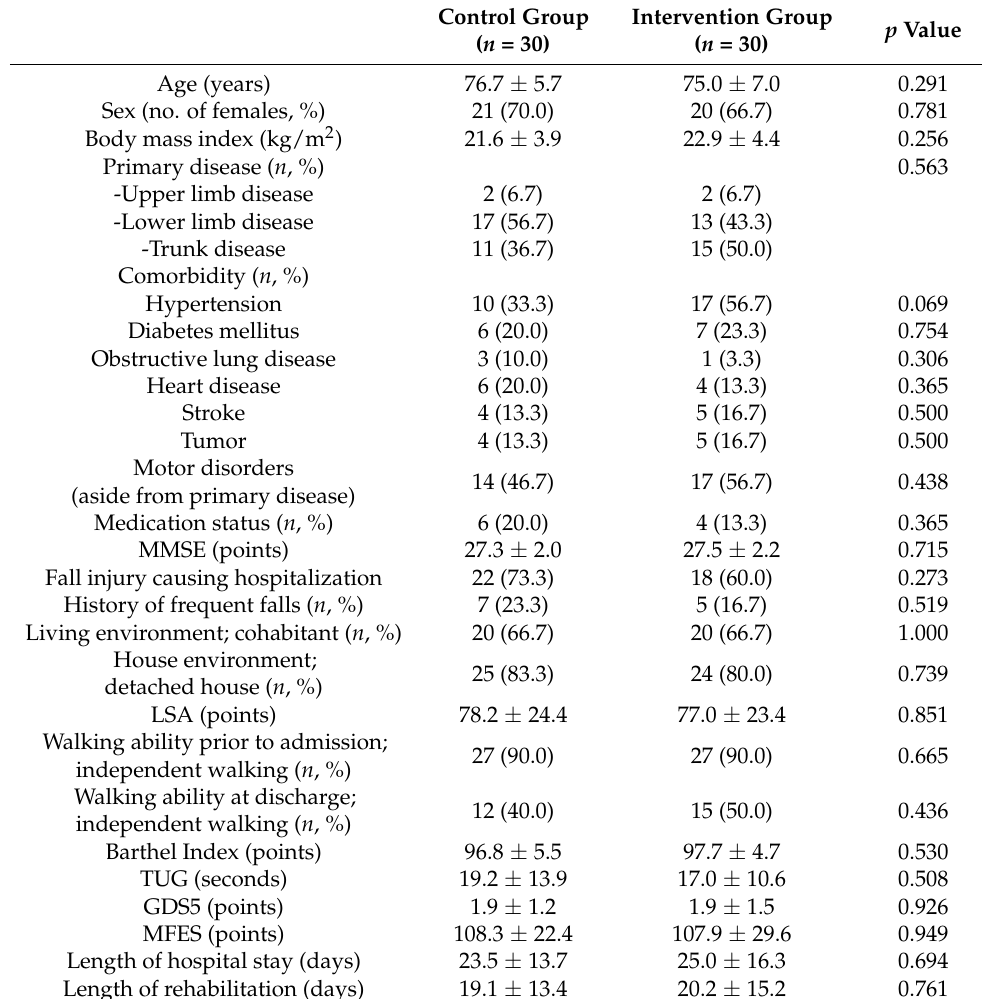
Table 1. Baseline comparison between the control and intervention